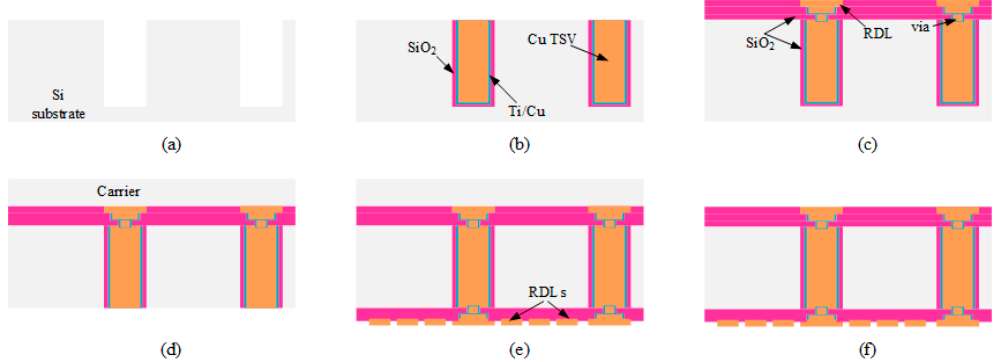
Figure 2. Schematic of the major fabrication steps:( a ) via formation, ( b ) via filling, ( c ) RDLs and vias formation, ( d ) Temporary bonding and backside grinding, ( e ) inductor formation, ( f ) TSV module assemble. Table 1. Comparison of the proposed backside integrated inductor with the prior integrated power inductors. Inductor Technology This work Backside integrated air